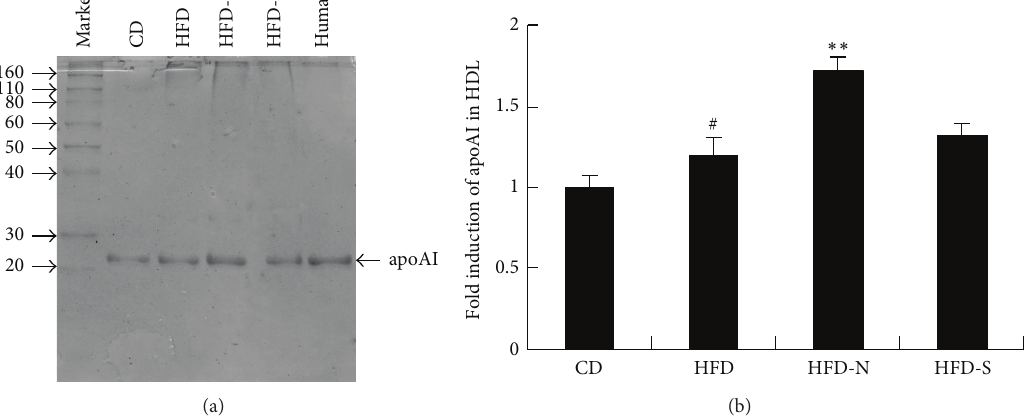
Figure 8: Niacin upregulated apoA I level in plasma of guinea pigs fed high fat diet. HDL (density = 1.09–1.24 g/mL) was separated from plasma of guinea pigs by sequential ultracentrifugation. The SDS-PAGE was performed on 15% SDS polyacrylamide gel, and the apolipoproteins were stained with coomassie brilliant blue. Densitometric quantitation of SDS-PAGE image was analyzed by Image-Pro Plus software.(a)showstherepresentativeSDS-PAGEimageofHDL.(b)showstherelativelevelofapoAIinplasmabydensitometricquantitation. Data are presented as mean ± SD of at least three independent experiments. # 𝑃 < 0.05 versus CD group; ∗∗ 𝑃 < 0.01 versus HFD